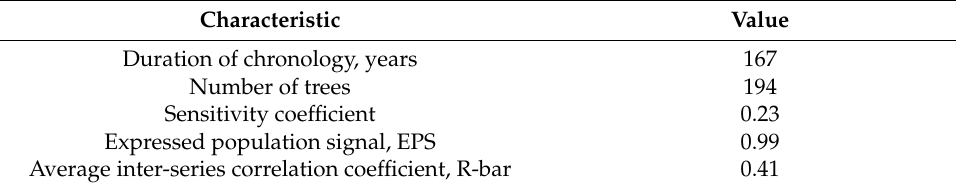
Figure 3. Location of the study sites (red circles) and the climatic station (black rectangle) in southern Siberia (Khakassia). Table 1. Statistical characteristics of individual trees in the study